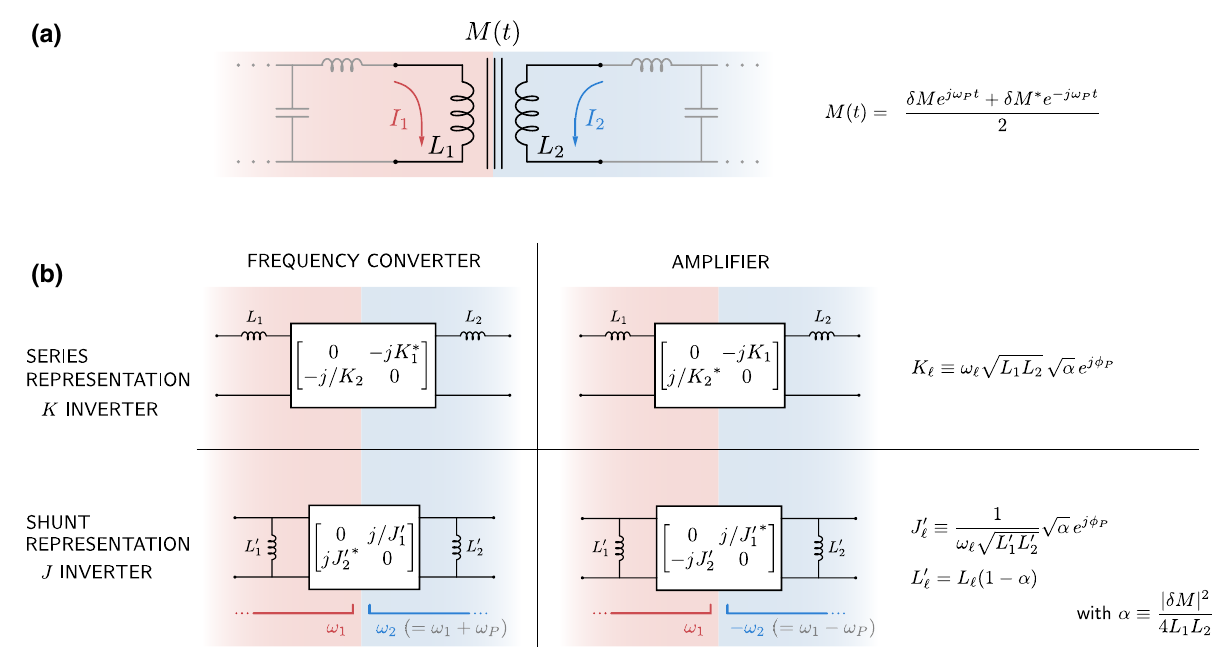
FIG. 9. (a) Modulated mutual inductance model with signal and idler branch currents I 1 and I 2 . An example embedding circuit is shown (grayed out) to provide context. (b) Equivalent two-port circuit models for the series and shunt representations of the modulated mutual. The boxed elements represent impedance or admittance inverters, with the corresponding ABCD matrices shown. The constants K (cid:11) , J (cid:12) (cid:11) , and L (cid:12) (cid:11) are defined in the